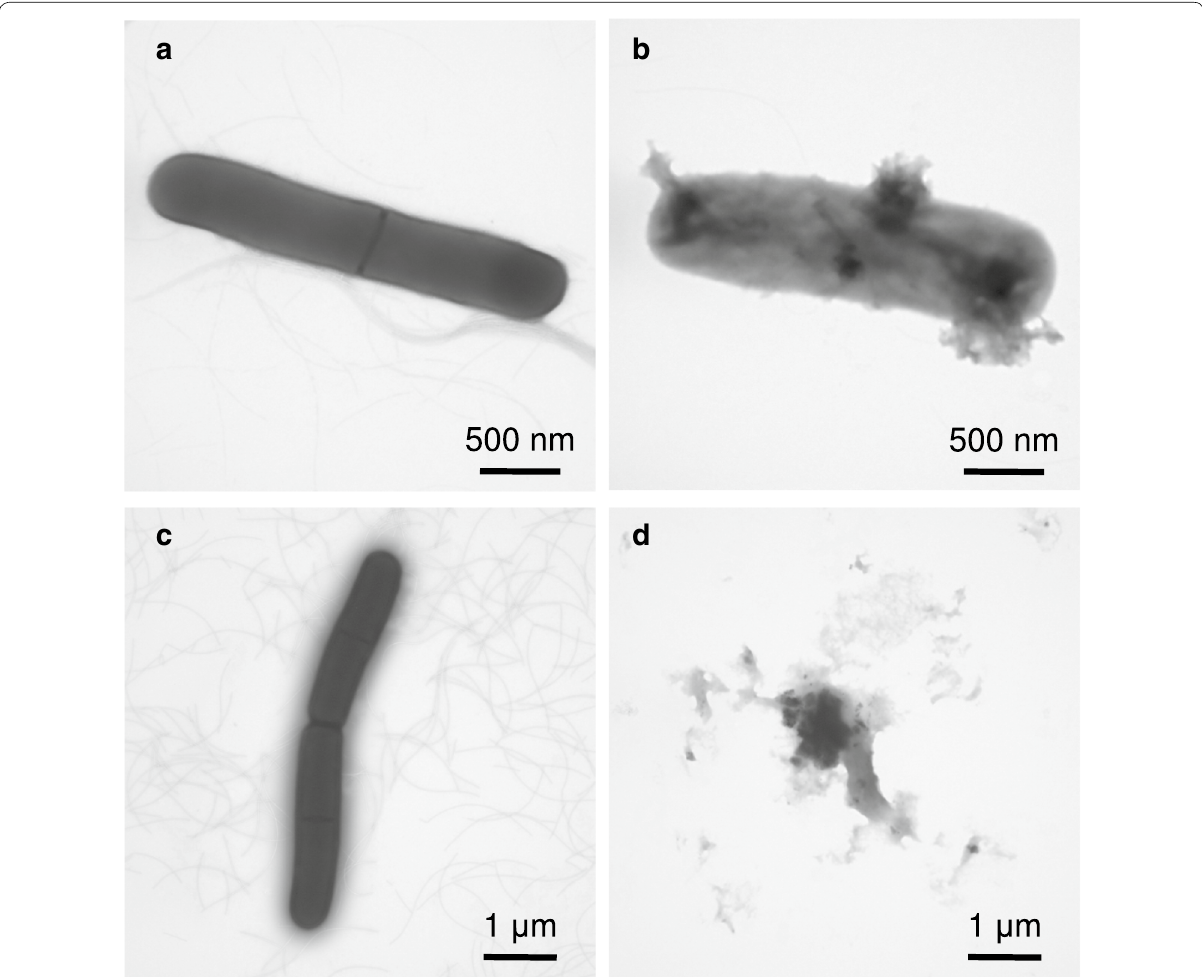
Fig. 6 TEM analysis with negative staining of B. subtilis AHU 1708 T cells cultured in the presence or absence of the Natto peptide. The cells were cultured in TH broth containing 5% (v/v) hemolysate in the absence ( a , c ) or presence ( b , d ) of the Natto peptide (64 μg/mL). After 4 h ( a , b ) or 8 h ( c , d ) of incubation, the cells were harvested and observed using TEM after negative